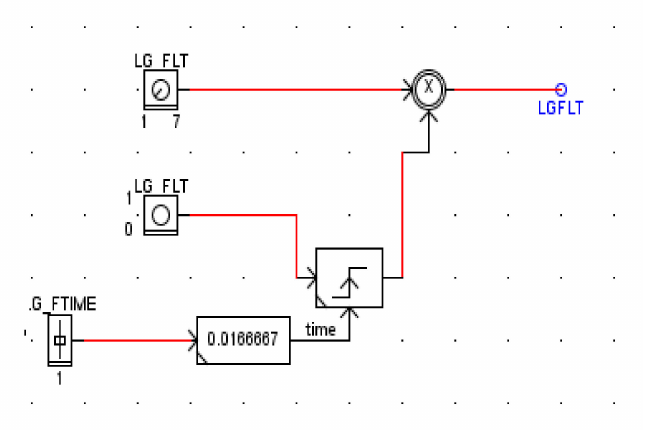
Figure 16. Fault scenario implemented in real time digital simulator